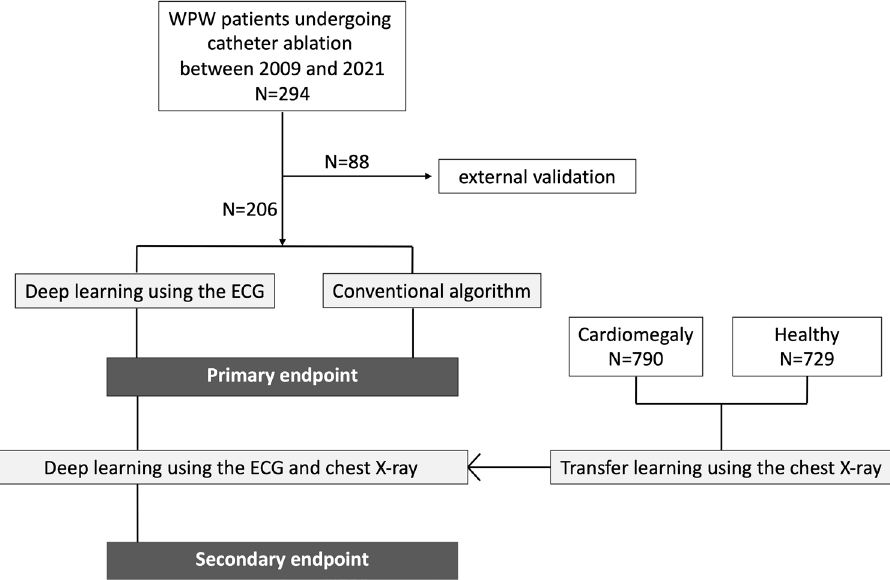
Figure 1. Study population and design. The primary endpoint was assessed by comparing the accuracy of each algorithm. The secondary endpoint was assessed by determining how the second model outcomes differed when the chest X-ray images were added into the model, rather than using only the